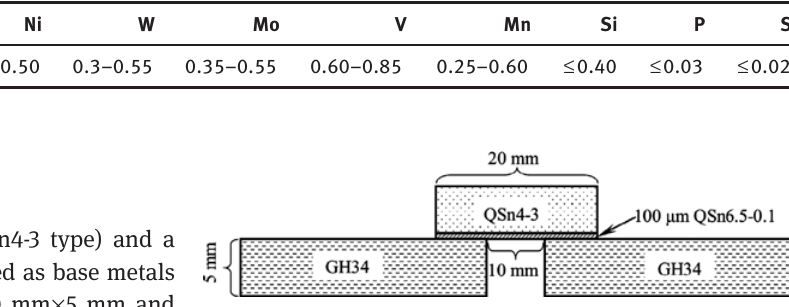
Figure 1 Assembly of the bonded joint.